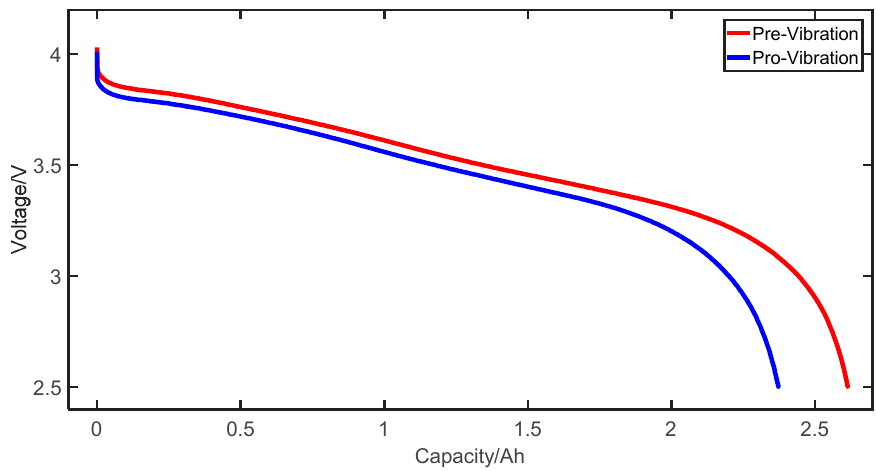
Figure 11. The discharge curves of batteries under pre-vibration and pro-vibration conditions.